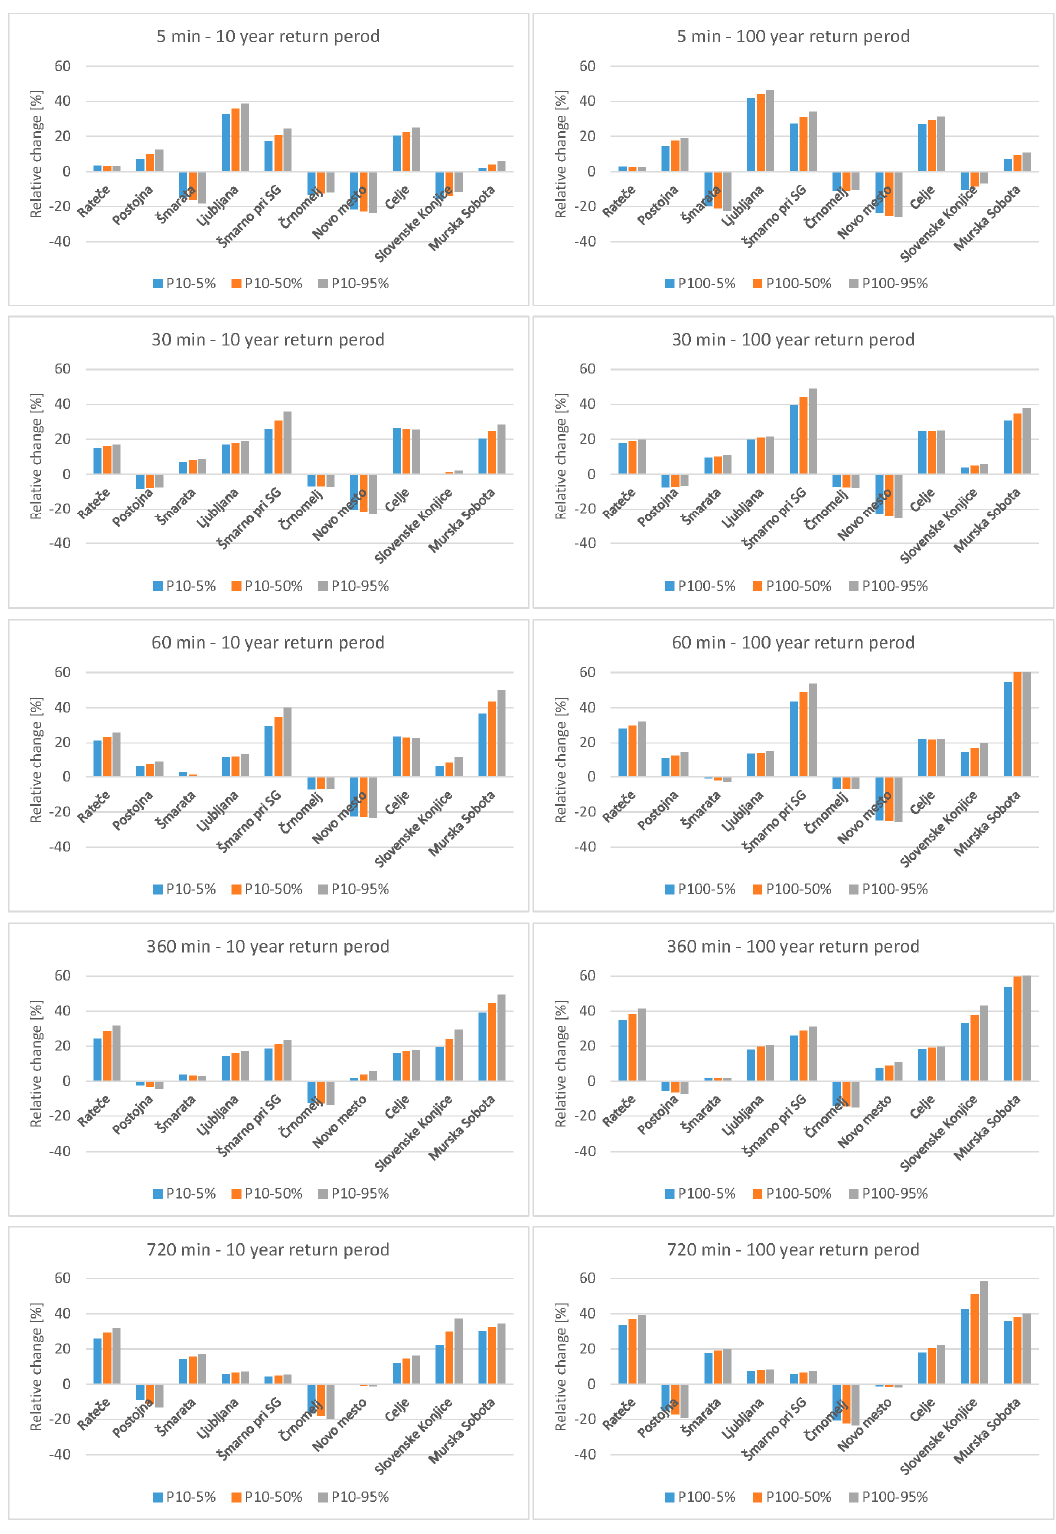
Figure 4. Relative changes in the intensity-duration-frequency (IDF) analysis results for the period from 1997–2018 (second 22 years) compared to 1975–1996 (first 22 years) for different rainfall durations and for the 10 and 100-years return period. The 5%, 50% (median), and 95% values are shown.